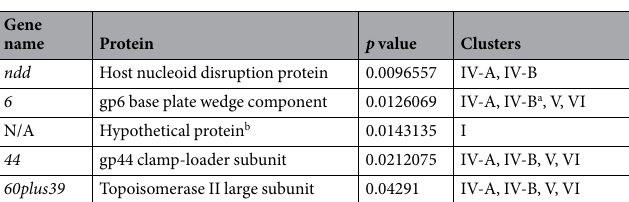
Table 2. Genes under positive selection. a The gene contains multiple frameshifts for AS4 and was consequently not added to the analysis. b de novo predicted by the present